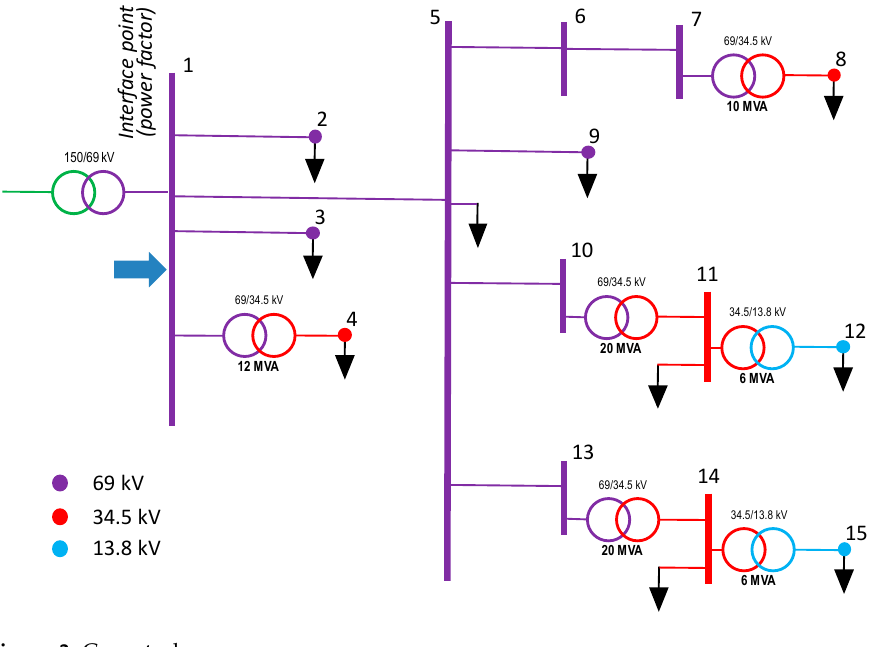
Table 1. Case study: electrical branch parameters (lines and transformers) and data nodes.